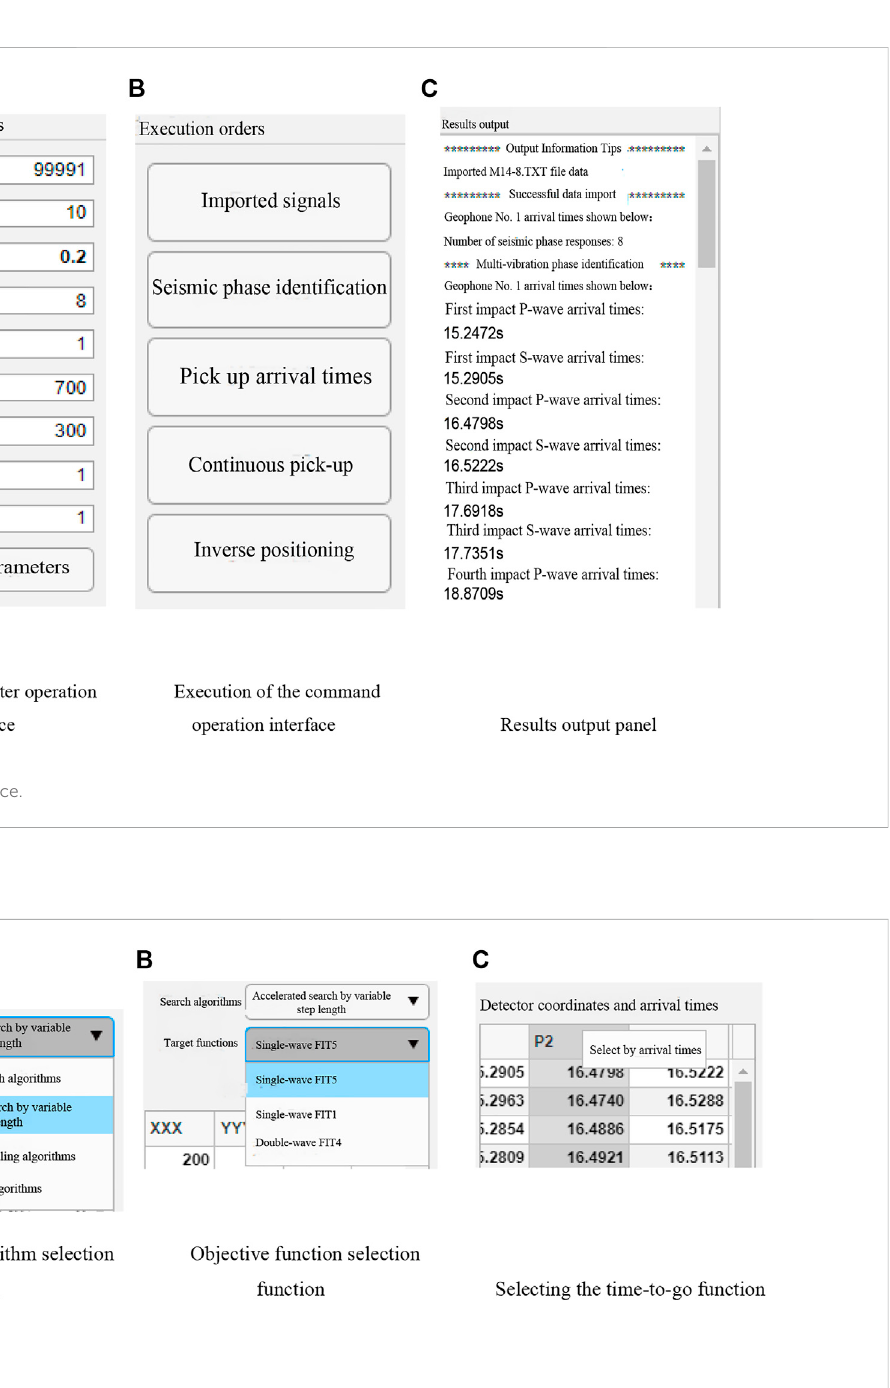
FIGURE 10 Display of some other